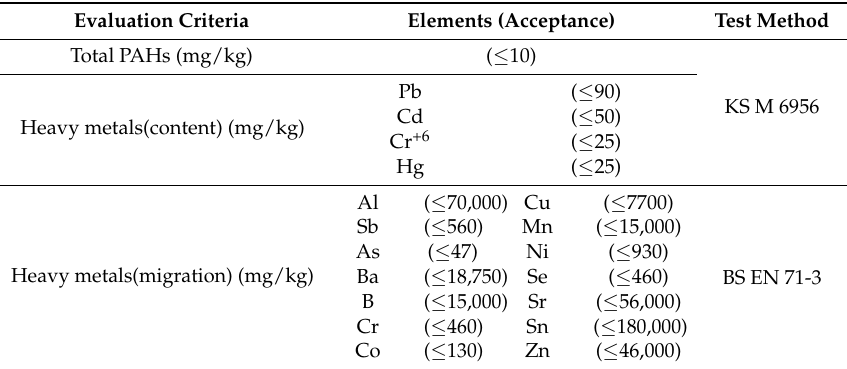
Table 2. Heavy metals test acceptance and method.